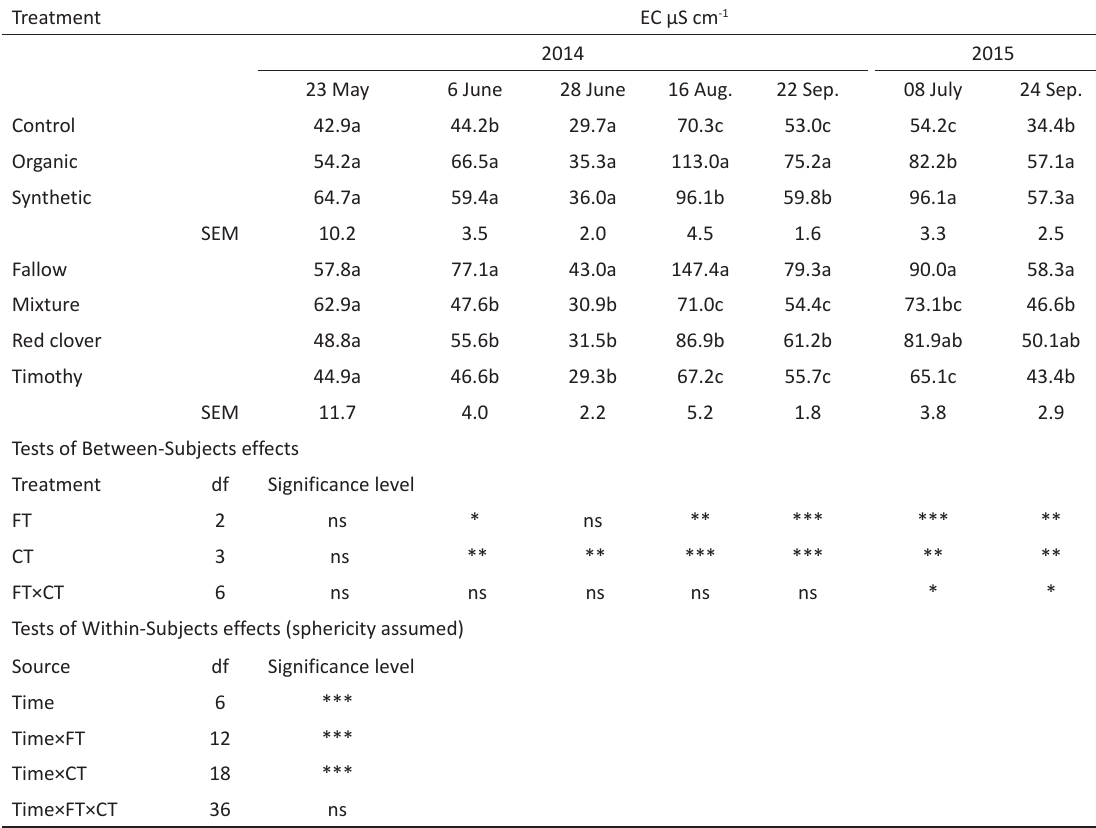
Table 6. Soil EC under different fertilizer and crop treatments Treatment